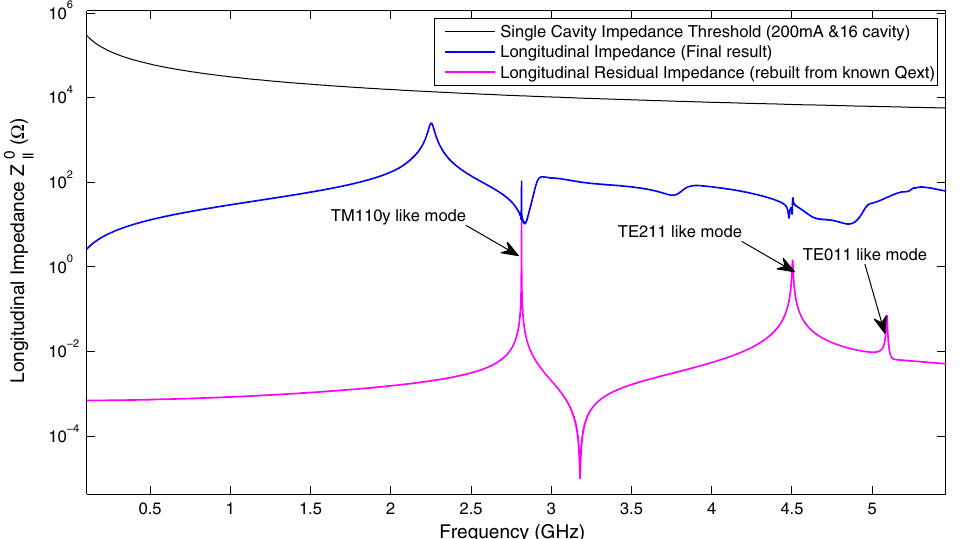
FIG. 11. Two wake impedances are shown in this figure. The pink curve shows the calculated resolved impedances in the frequency domain. The blue curve shows the fully-resolved longitudinal impedance Z 0 ∥ based on the Z 60 m 0